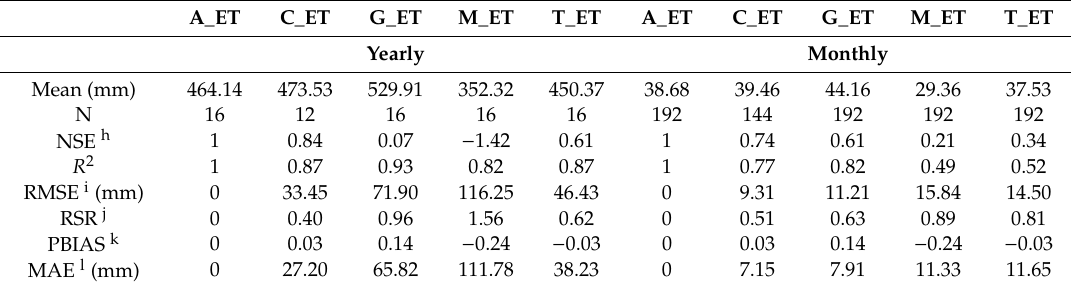
Table 2. Comparison of the four evapotranspiration (ET) products with the AWAP ET. A_ET C_ET